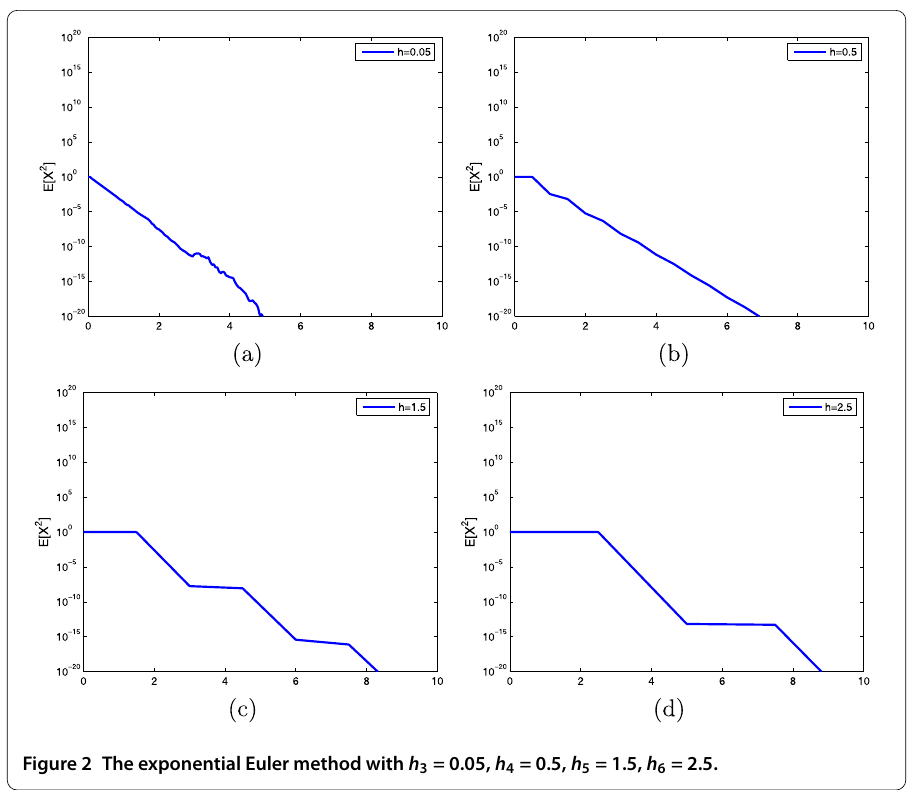
Figure 2 The exponential Euler method with h 3 = 0.05, h 4 = 0.5, h 5 = 1.5, h 6 = 2.5.